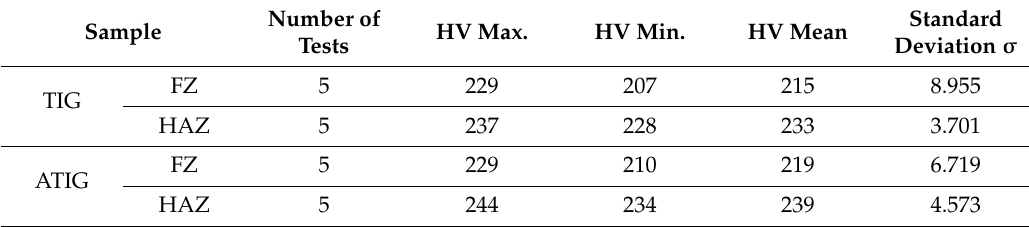
Table 9. Mesurments of energy absorbed and standards deviation of TIG and ATIG (optimal flux) at fusion zone.